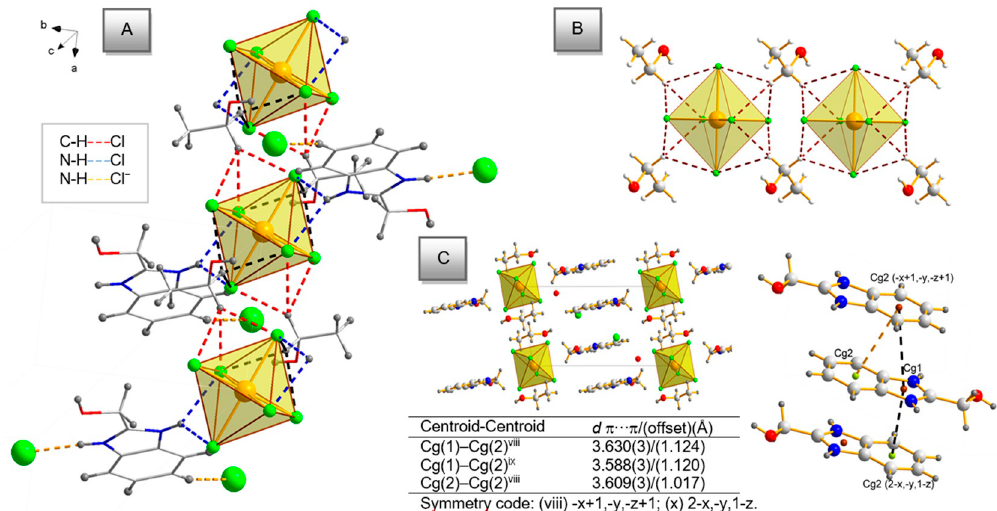
Figure 2. Crystal packing of complex 1 with supramolecular architecture: ( A ) a view of the coordination environment of Ru(IV) ion containing N-H ··· Cl and C-H ··· Cl hydrogen bonding; ( B ) the network of hydrogen-bonded ribbons along [1 0 0] of alternating hexachlororuthenium(IV) and ethanol units (ethanol molecules act as ”molecular clips”); ( C ) the layers parallel to (0 1 0) of discrete centrosymmetric [RuCl 6 ] 2 − octahedra and 2-(hydroxymethyl)-1 H -benzimidazol-3-ium ions and the geometry of the π ··· π stacking interactions (Cg(1): 5-membered ring defined by: N(1), C(2), N(3), C(9), C(8) atoms; Cg(2): 6-membered ring defined by C(4), C(5), C(6), C(7), C(8), and C(9) atoms).